Question: Which visualization type does this figure use?
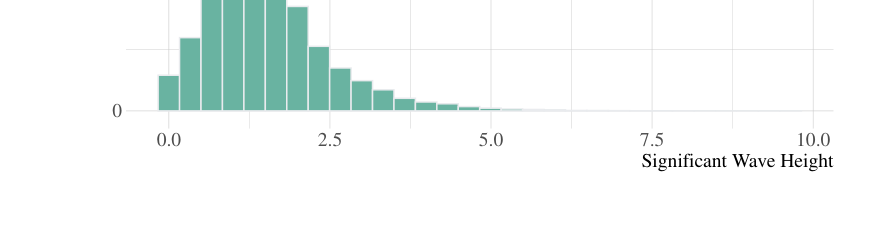
Answer: histogram